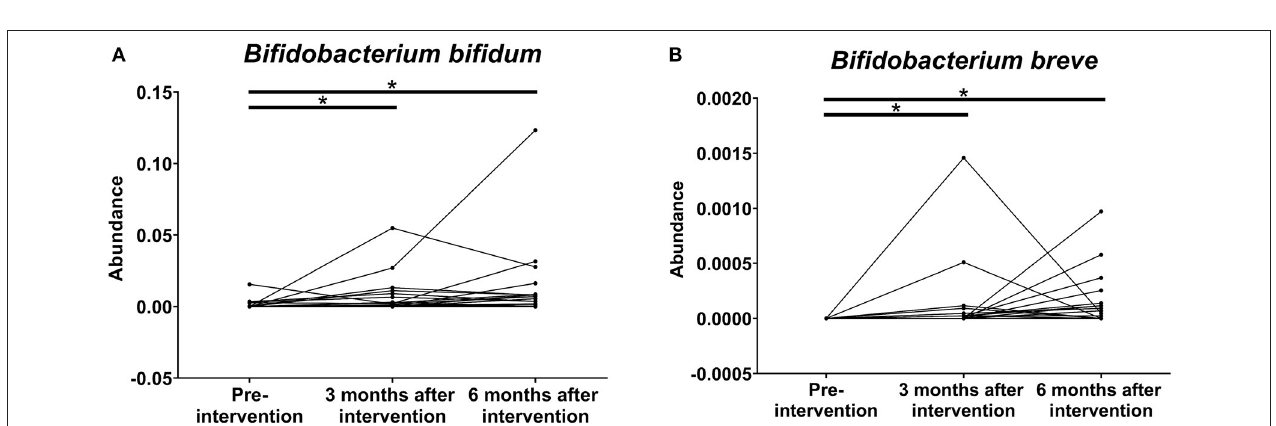
FIGURE 6 | Effects of probiotics on the relative abundance of (A) B. bifidum and (B) B. breve on the stool microbiota at pre-intervention as well as 3 and 6 months after probiotic intervention in patients with chronic kidney disease (* P < 0.001).